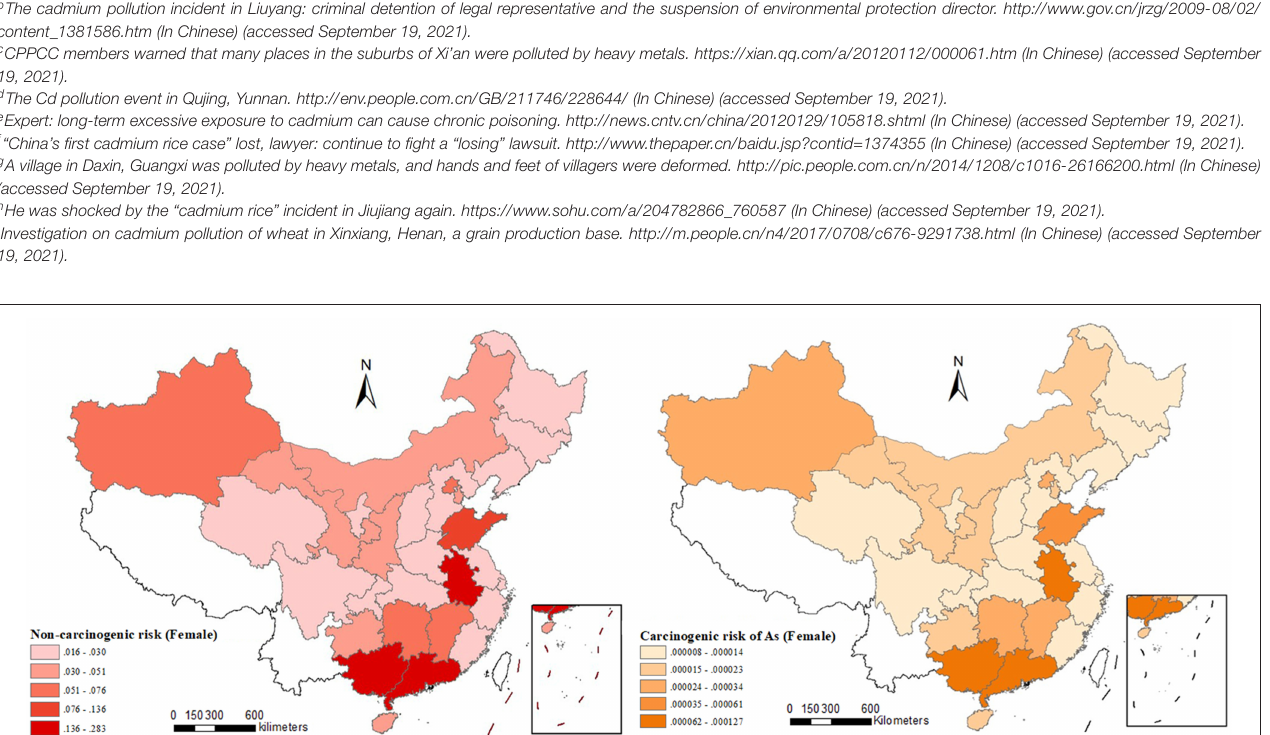
Long-term use of sewage for irrigation will pollute cropland and agricultural products with excessive heavy metal and pathogens. Table 4 lists the heavy metal/metalloid concentration